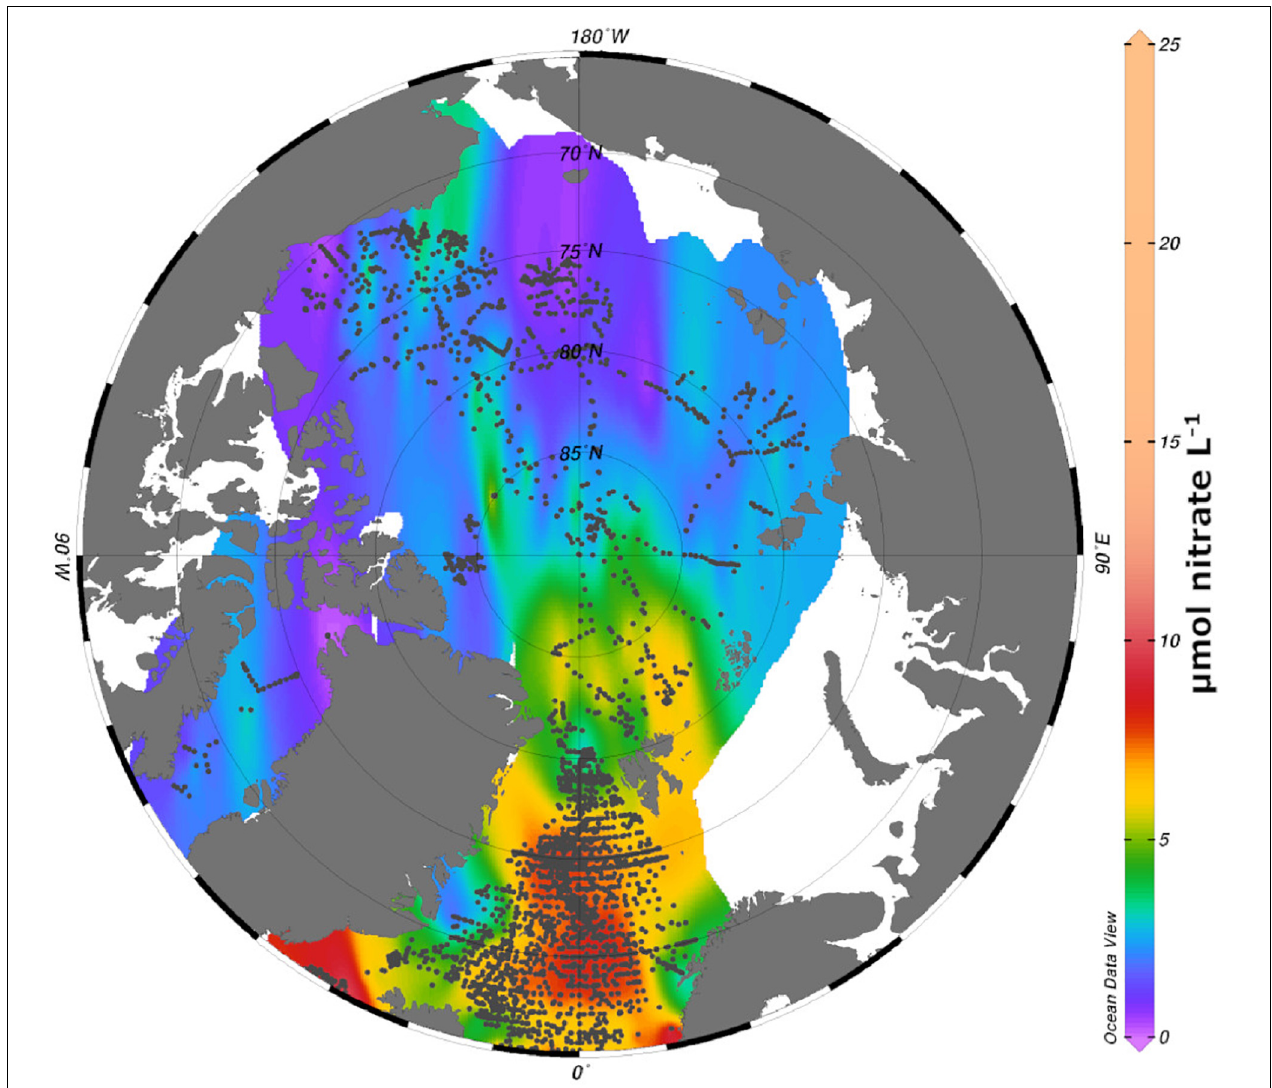
FIGURE 2 | Compilation of nitrate concentrations ( µ mol nitrate L 1 , gray filled circles) in the Arctic basins and adjacent oceans (at stations with a bottom depth > 1000 m). Data extracted from the World Ocean Database 2018. Extrapolated nitrate concentrations includes also shallower